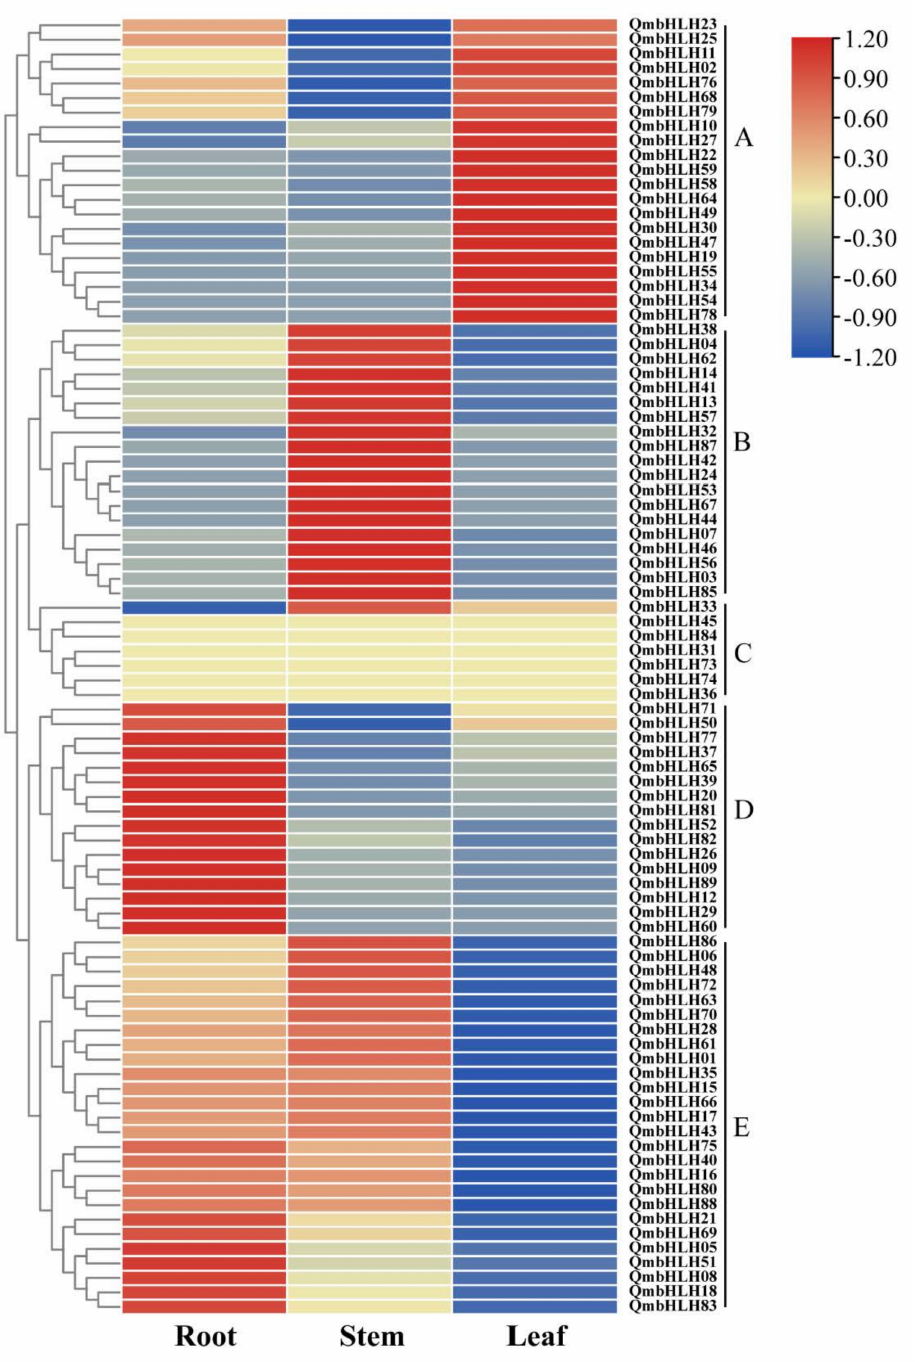
Figure 7. Expression profiles of QmbHLH genes in various tissues. The heat map was constructed according to the standardized FPKM values with clustering. The transition from blue to red represents diverse levels of expression. QmbHLH expression patterns were classified into five major groups and represented by A-E based on cluster